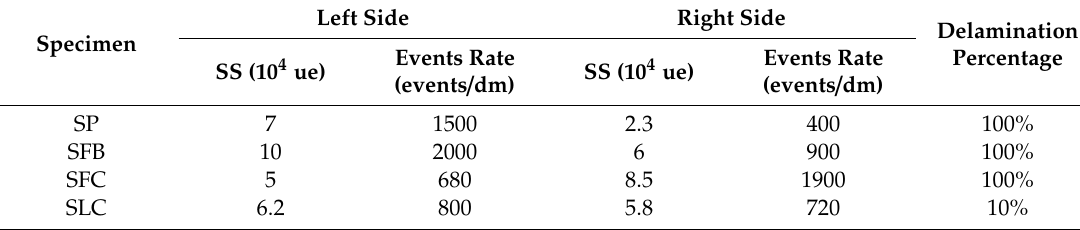
Table 6. Delamination criteria based on AE futures: SS (signal strength), located events rate. Left Side Right Specimen